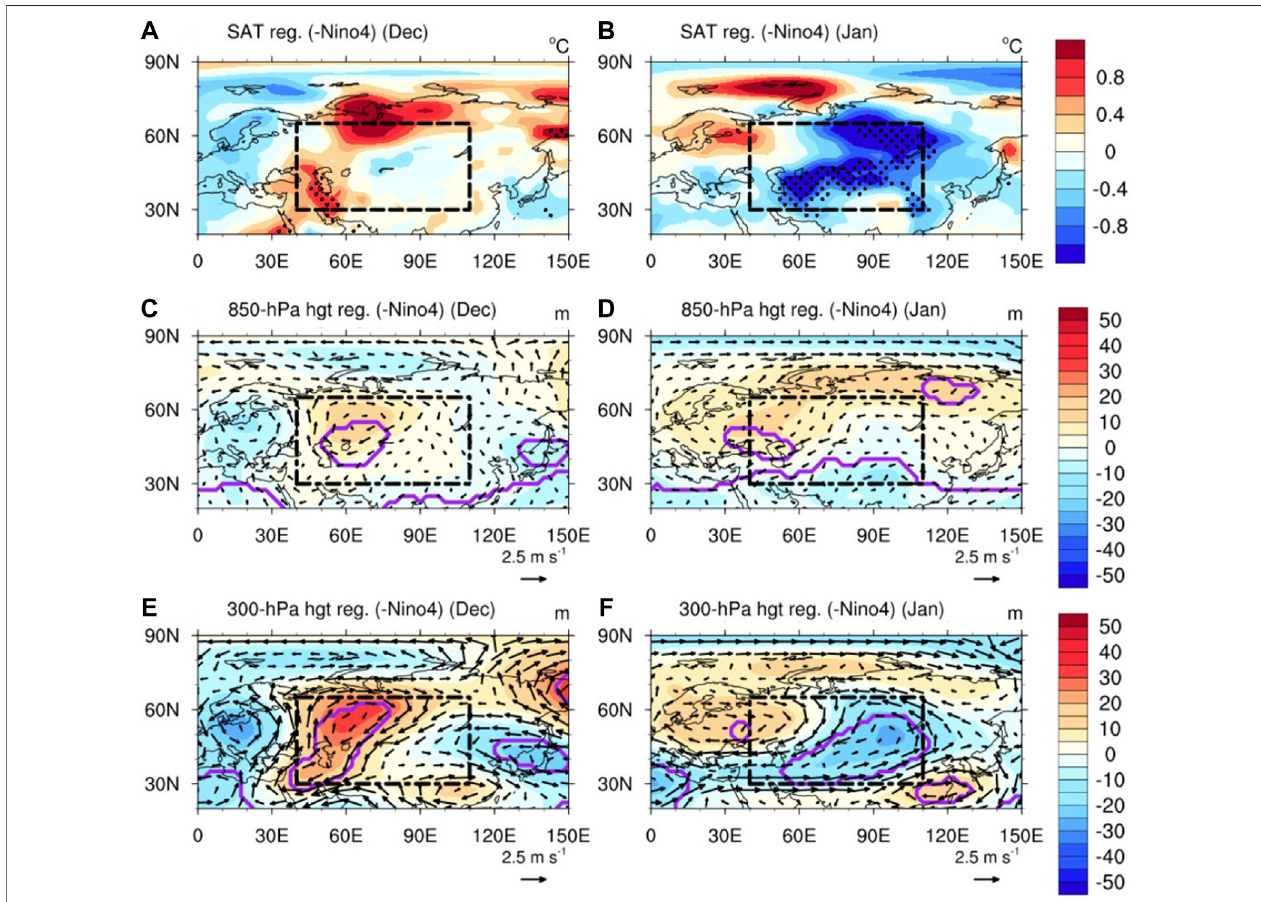
FIGURE5| RegressionsofDecember (A) SAT(shading; ° C)and (C) 850 hPaand (E) 300 hPageopotentialheight(shading;m)andwinds(vectors;m s − 1 )ontothe − Niño4 for the period 1979 – 2017 (B,D,F) As in (A,C,E) but for January during 1980 – 2018. The black dashed boxes show the region of CA; anomalies signi fi cant at the 95% con fi dence level are denoted by dots and purple contour lines, as estimated by the Student ’ s t- test.